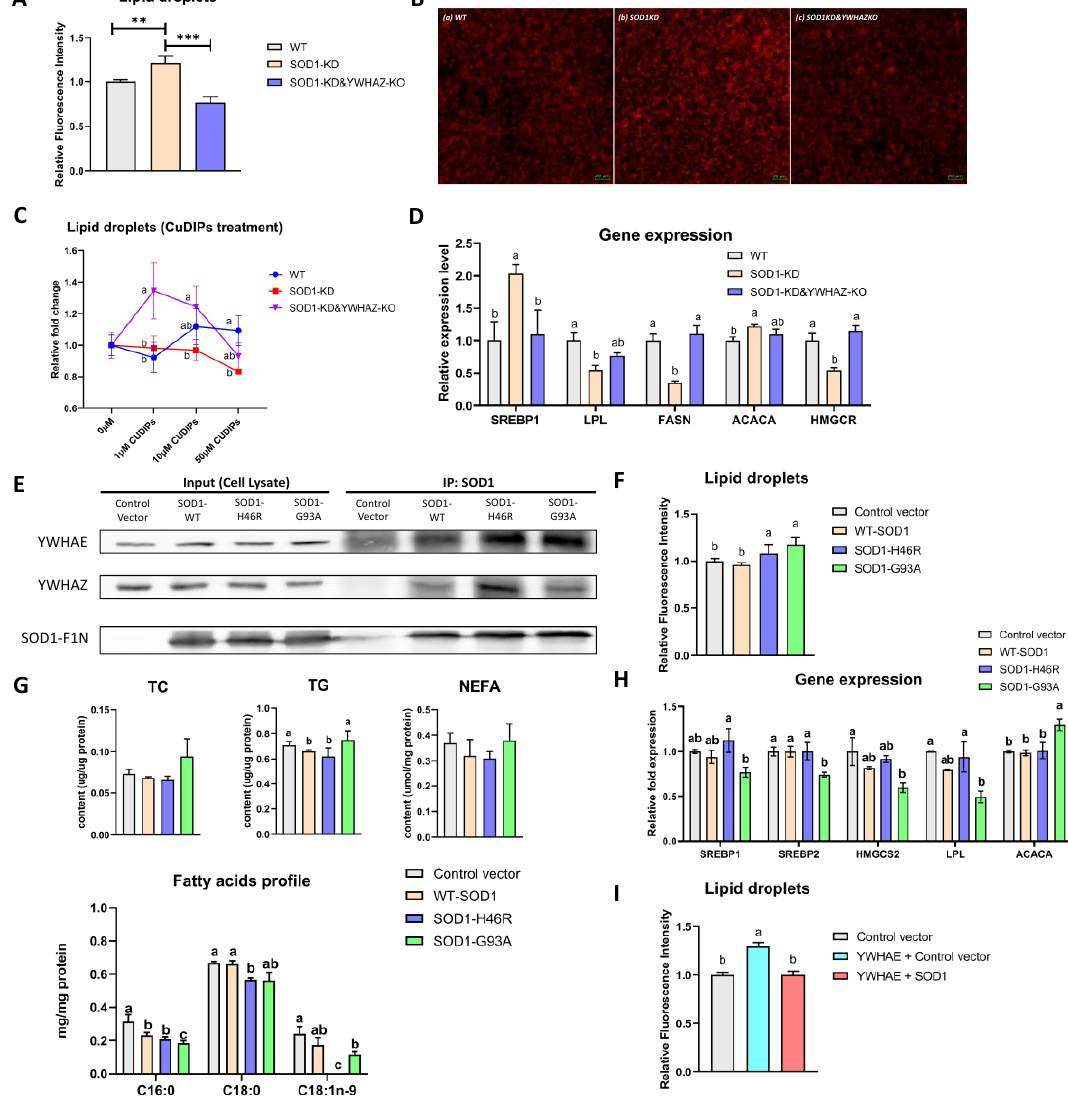
Figure 5. Impacts of the disrupted SOD1 and YWHAZ or YWHAE protein–protein interactions on cellular lipid metabolism in SOD1 and YWHAZ genome-edited HEK293T cells or HepG2 cells overexpressing SOD1 mutants. ( A ) Quantification of lipid droplets in vivo staining by Nile red assay in WT, SOD1-KD, and and SOD1-KD&YWHAZ-KO HEK293T cells. ( B ) Fluorescent images of Nile red-stained genome-edited cells. Annotation : ( a ): WT (Wild type), ( b ): SOD1-KD (SOD1 knockdown), ( c ): SOD1-KD&YWHAZ-KO (SOD1 knockdown and YWHAZ knockout), Scale bar, 20 μm. The image was representative of three sets of data. ( C ) Quantification of lipid droplets in vivo staining by Nile red assay under treatments of graded levels of CuDIPs for 48 h in WT, SOD1-KD, and SOD1-KD&YWHAZ-KO HEK293T cells. ( D ) Relative mRNA levels of lipid metabolism genes WT, SOD1-KD, and SOD1-KD&YWHAZ-KO HEK293T cells ( n = 4). ( E ) Co-immunoprecipitation of YWHAE and YWHAZ pulled down by SOD1 antibody in HepG2 overexpressing WT-SOD1-F1N, mutant SOD1-F1N (H46R and G93A), or F1N control vector. The cell lysates were used as positive controls